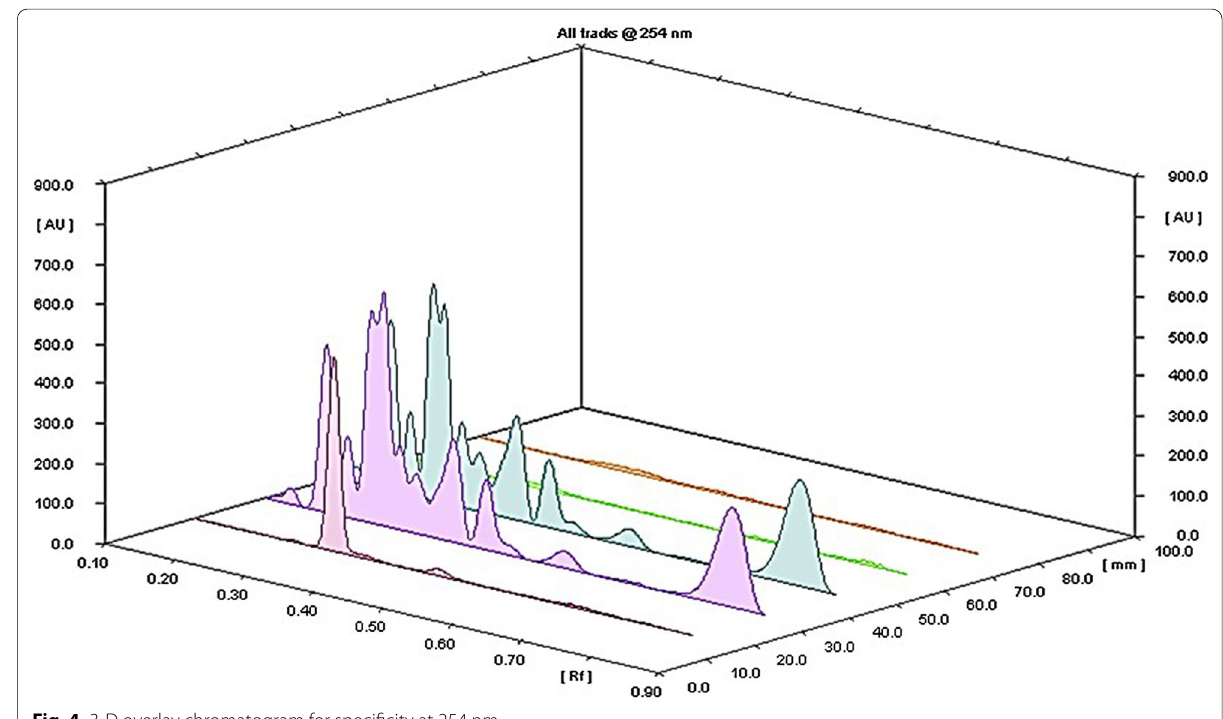
Fig. 4 3-D overlay chromatogram for specificity at 254 nm